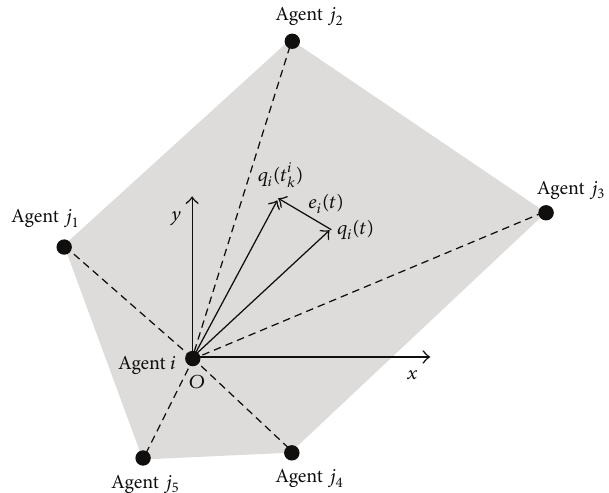
Figure 1: Target state and measurement error of agent 𝑖